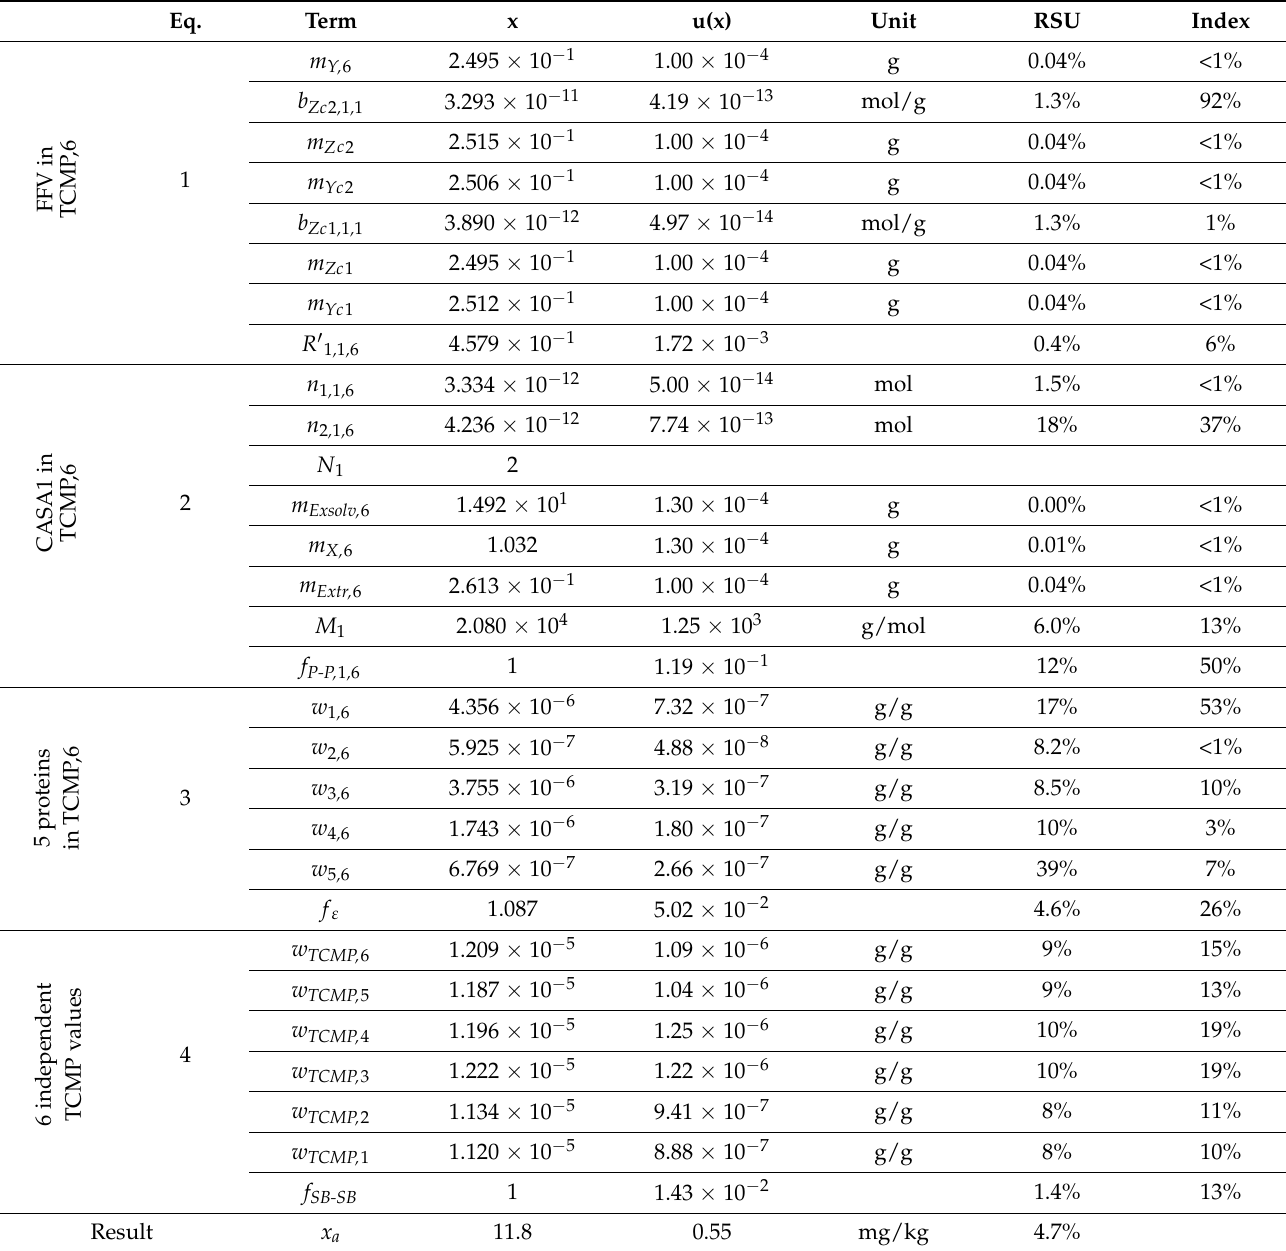
Table 2. Uncertainty budget starting with peptide FFV ( i = 1) of protein CASA1 ( j = 1) in SB U167.2 (k =